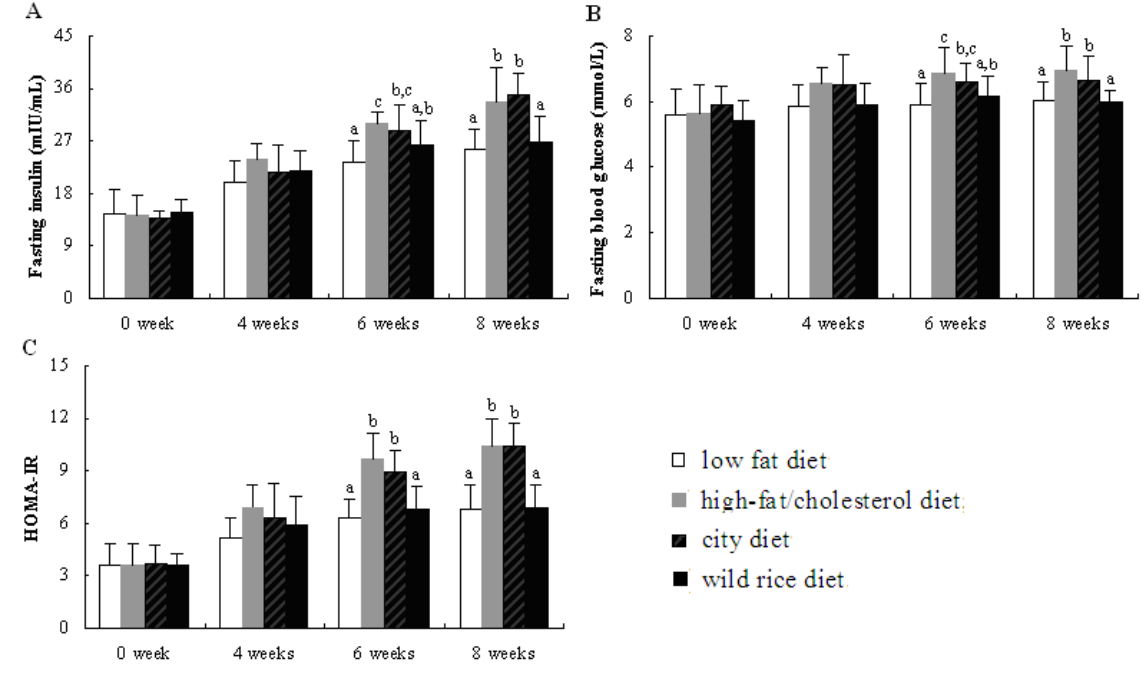
Figure 1. Effects of different experimental diets on glucose and insulin sensitivity in rats. Data are expressed as the mean ± SD for 10 rats. Bars without a common superscript letter indicate significant differences among groups at p < 0.05.